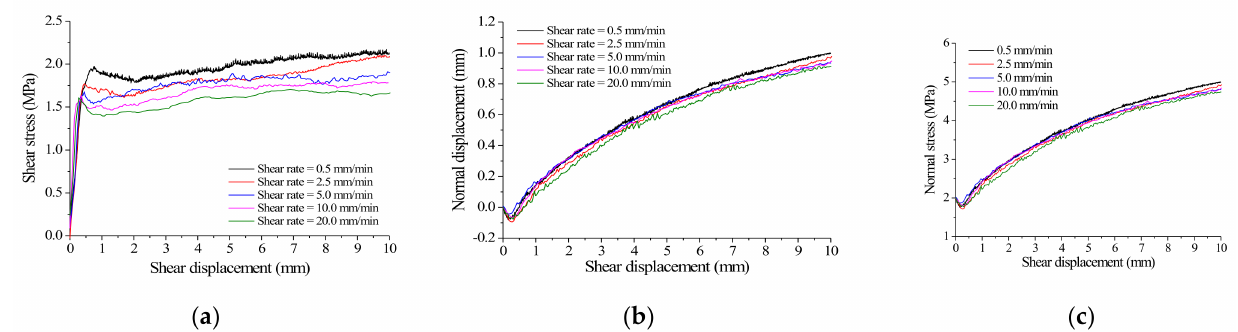
Figure 8. Shear behaviors of joints with different shear rates under CNS conditions. ( a ) Shear stress versus shear displacement of joints. ( b ) Normal displacement versus shear displacement of joints. ( c ) Normal stress versus shear displacement of joints.